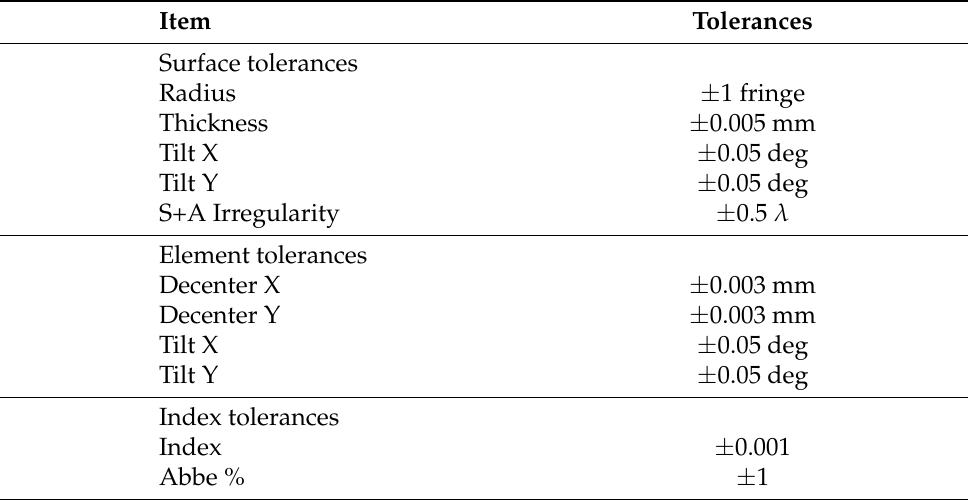
Table 4. Fabrication tolerances of the optimized system.